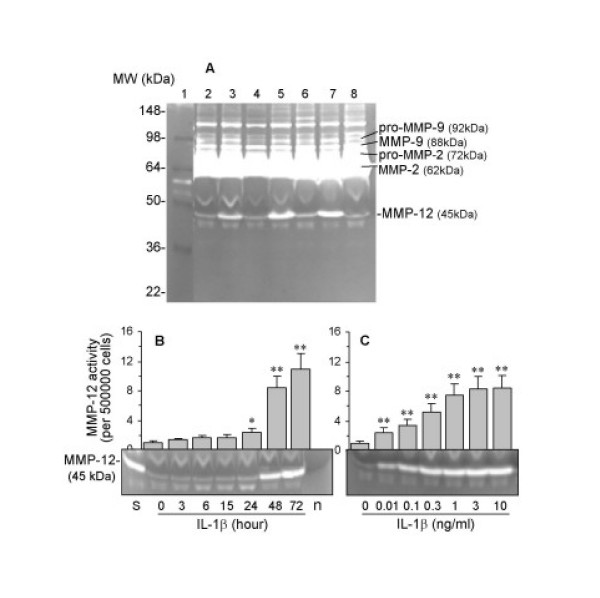
Activity of MMP-12 secreted by ASMC and stimulation by IL-1β. (A) Gelatin zymography detection of activity of MMPs released into the conditioned media by ASMC treated for 48 hours (lane 1, protein markers; lane 2, control; lane 3, 10 ng/ml IL-1β; lane 4, 10 ng/ml TGF-β; lane 5, TGF-β plus IL-1β; lane 6, 10 ng/ml TNF-α; lane 7, TNF-α plus IL-1β; lane 8, 10 ng/ml IL-13). (B) Time-dependent stimulation of MMP-12 activity by 10 ng/ml IL-1β. Lane s, human MMP-12 standard protein used as a positive control. Lane n, negative control. (C) Concentration-dependent stimulation of MMP-12 activity by IL-1β for 48 hours. Relevant band intensities were quantified by scanning densitometric analysis and normalized to 5 × 105 cells. Results are the mean ± SEM from three ASMC donors. *P < 0.05, **P < 0.01 compared with control.